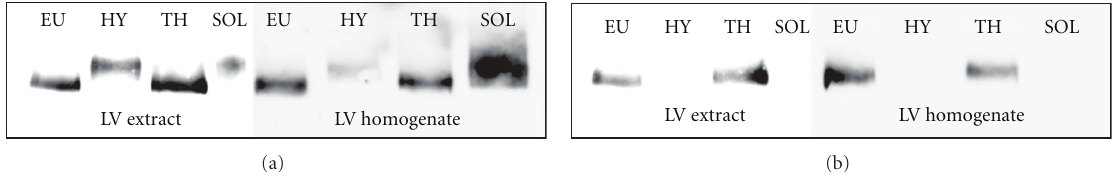
Figure 2: Western blot immunodetection of cardiac MyHC isoforms from left ventricle (LV) homogenates and extracts of adult euthyroid (EU), hypothyroid (HY), and hyperthyroid (TH) Lewis rats. The membranes were stained by NB300-284 antibody recognizing both MyHC α and MyHC β isoforms (a) or by BA.G5 antibody, which was solely specific for cardiac MyHC α isoform (b).